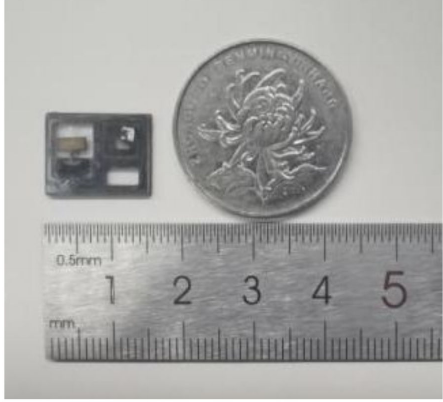
Figure 7. Image of the MEMS microparticle